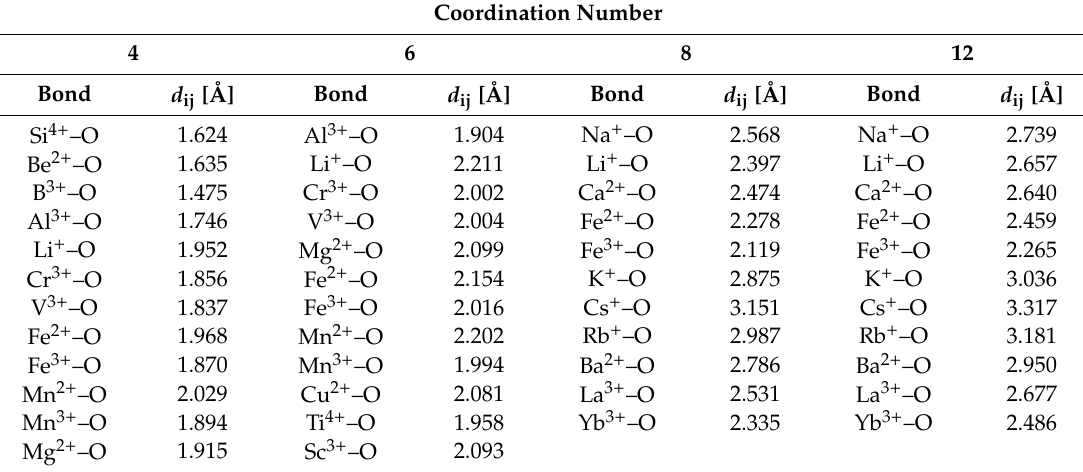
Table 1. Calculated bond lengths ( d ij ) for selected cation–oxygen bonds in specific coordination environments occurring in the beryl structure.